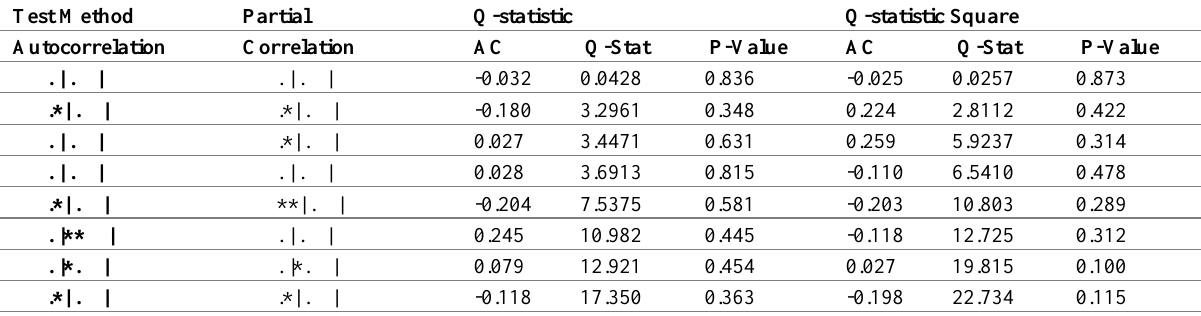
Table 6: Residual Serial Correlation Test Q-statistic Dynamic Regressors